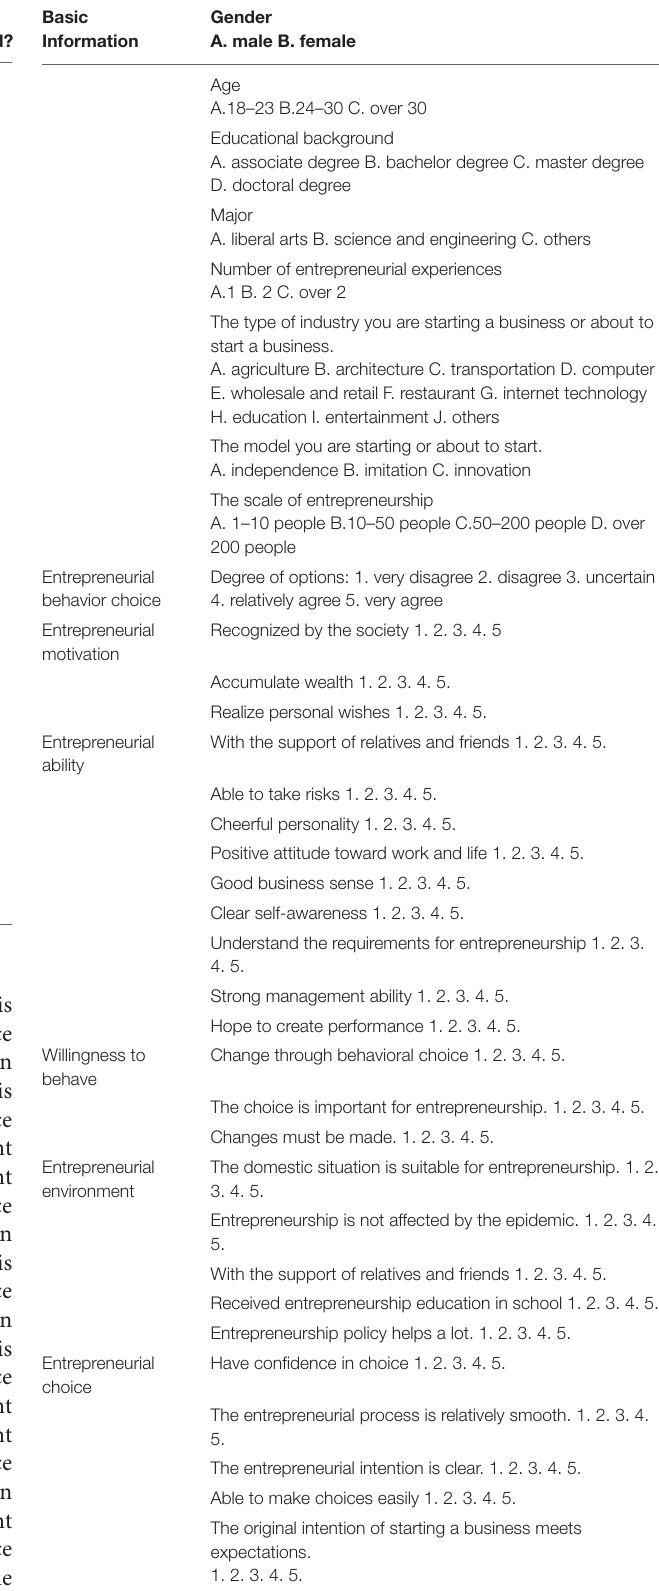
TABLE 5 | Questionnaire on entrepreneurship behavior choice. P -value Is it Basic factor judgment established?